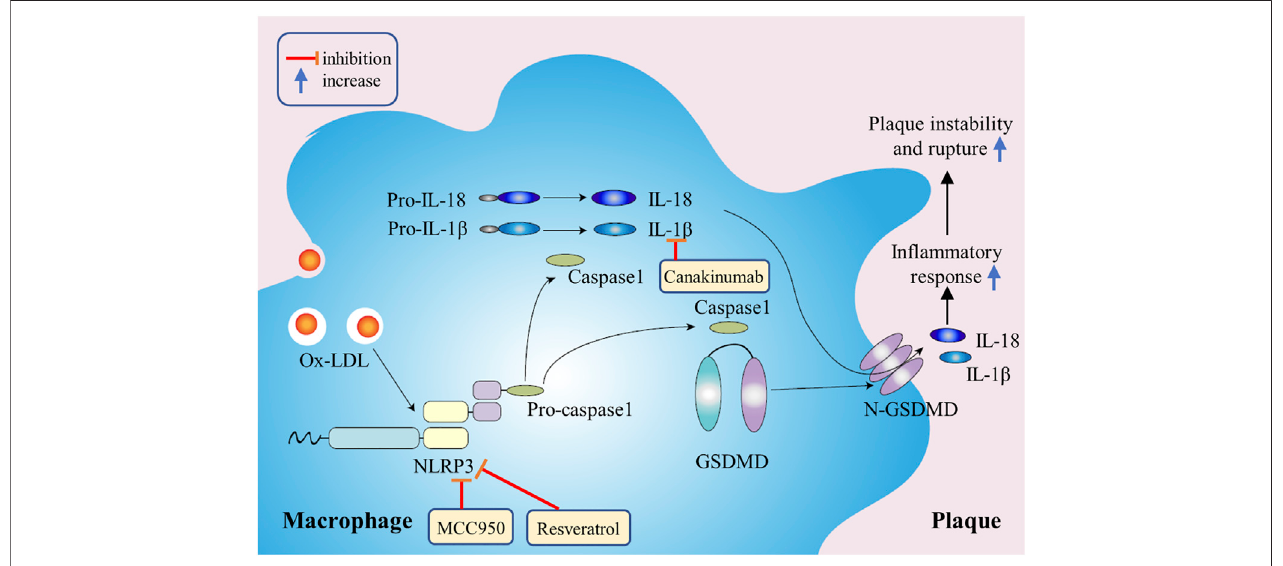
FIGURE3| Themechanismofmacrophagepyroptosisinpromotingatherosclerosis.Ox-LDLinplaqueswillcontinuouslyactivateNLRP3in fl ammatorybodiesand caspase-1, resulting in a continuous increase in the release of in fl ammatory factors, thus promoting plaque instability and rupture.